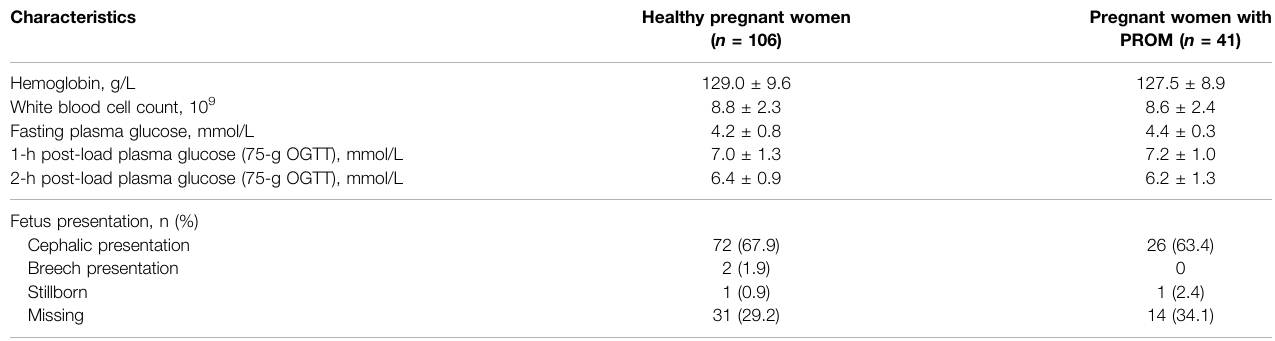
TABLE 2 | Maternal characteristics in healthy and PROM cohorts in the third trimester.